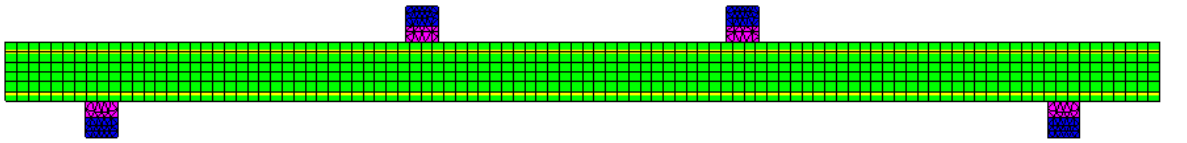
Figure 1. 2D basic model of a concrete slab for the four-point bending test created in GiD software. Distance of support is 300 mm; distance of loading support is 100 mm.